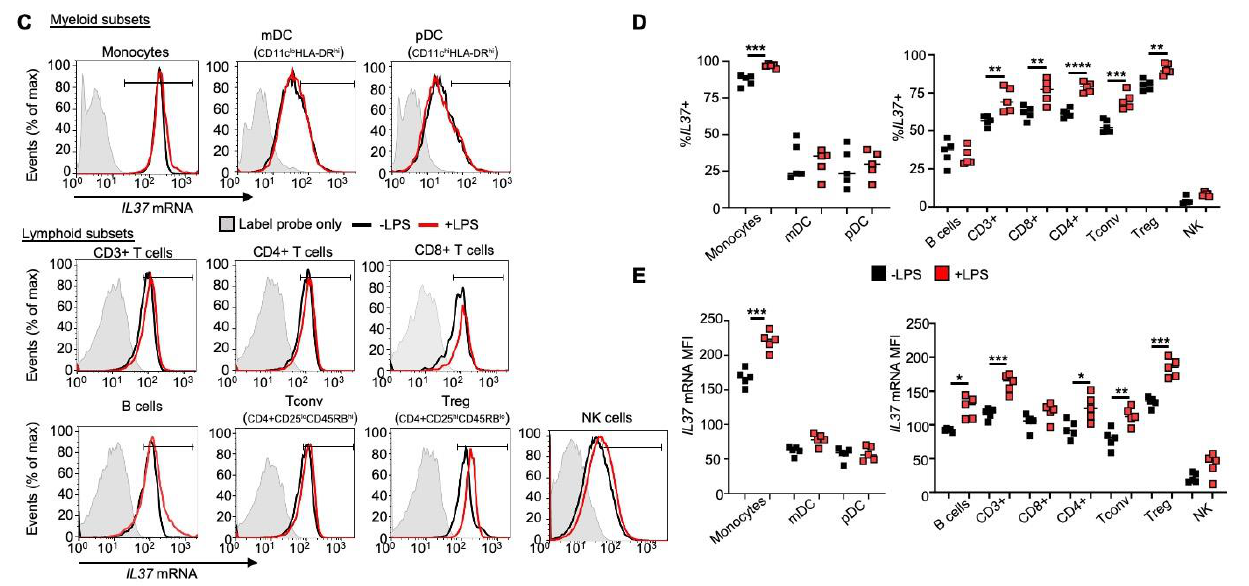
Figure 1. Identification of IL37 -expressing cells in human PBMCs using a flow cytometry-based PrimeFlow ® RNA assay. ( A , B ) Myeloid ( A ) and lymphoid cell ( B ) gating strategy analyzing the expression of cell surface proteins and IL37 mRNA from immune cells. ( C – E ) Histogram ( C ) and quantification by frequency ( D ) and mean fluorescent intensity (MFI) ( E ) of IL37 mRNA expression in myeloid and lymphoid cell subsets. PBMCs were treated in the absence (-), black lines or black symbols) or presence (+, red lines or red symbols) of 100 ng/mL LPS for 24 h. A gray histogram represents the fluorescence of the label probe only (background) for each immune cell subset as a negative control. Gating for determining positive cell frequency was established to exclude ~99% of the control events as negative. RPL13a mRNA served as an internal control (not shown). Each symbol represents an individual donor; small horizontal lines indicate mean ± s.e.m., (n = 5 donors per group) ( A – E ). * p < 0.05; ** p < 0.01; *** p < 0.001; **** p < 0.001 (Student’s t -test). Data are